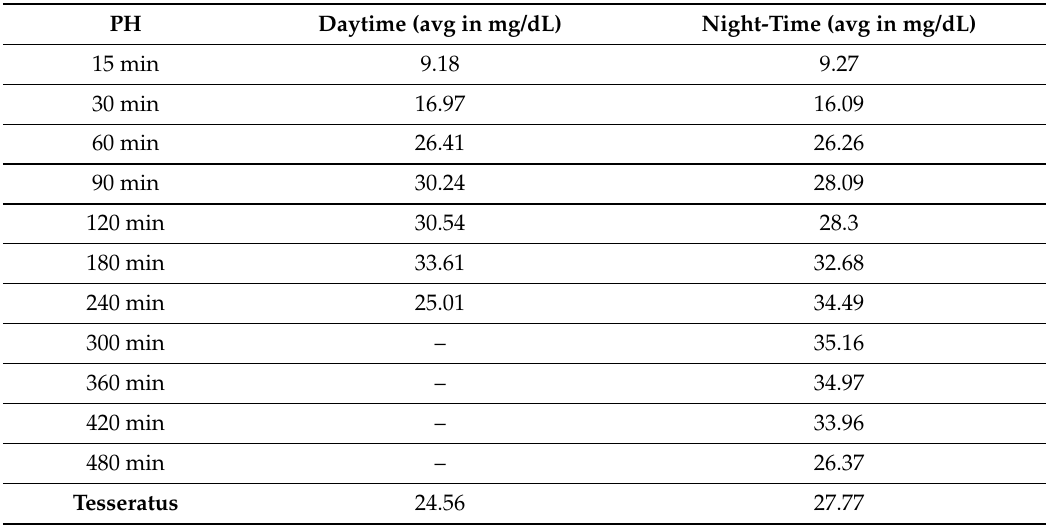
Table 9. Mean Absolut Error (MAE)—daytime and nighttime comparison of PH concerning seven T1D individuals. General average MAE at daytime and nighttime for Tesseratus.